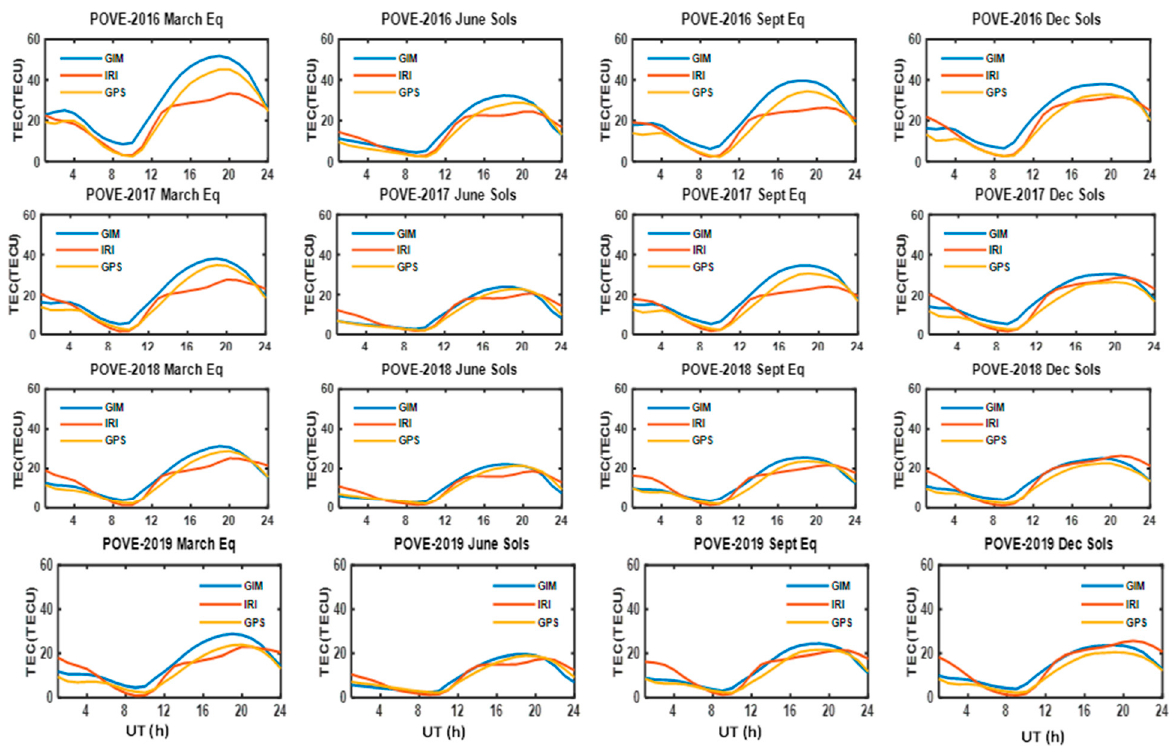
Figure 7. Seasonal variations in GPS-TEC, IRI-2016 and GIM models for descending (2016–2017) and minimum (2018–2019) phases of solar cycle 24 at POVE.